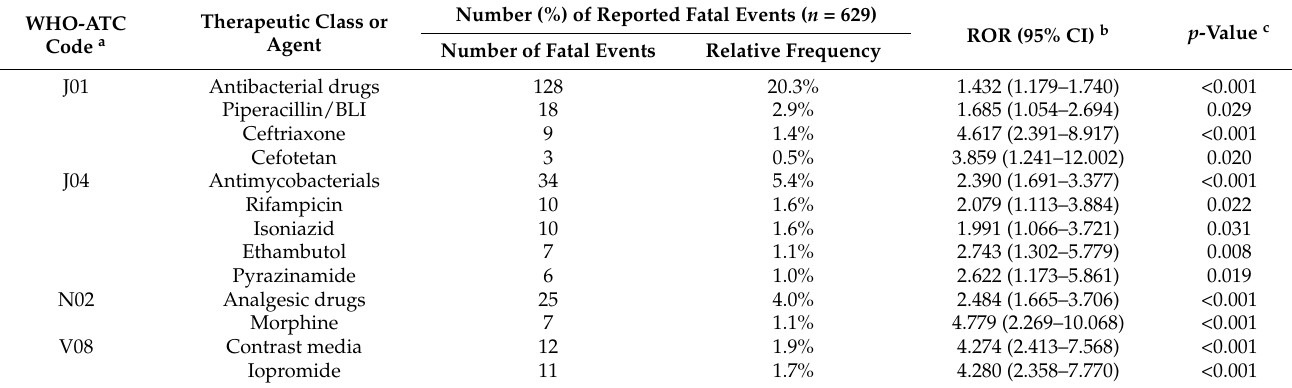
Table 2. Causative agents significantly associated with fatal adverse drug